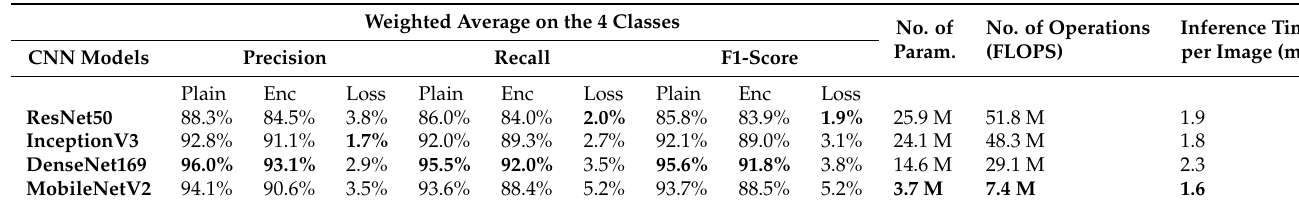
Table 4. Performance of the 4 CNN models on the validation set of the plain and encrypted data.